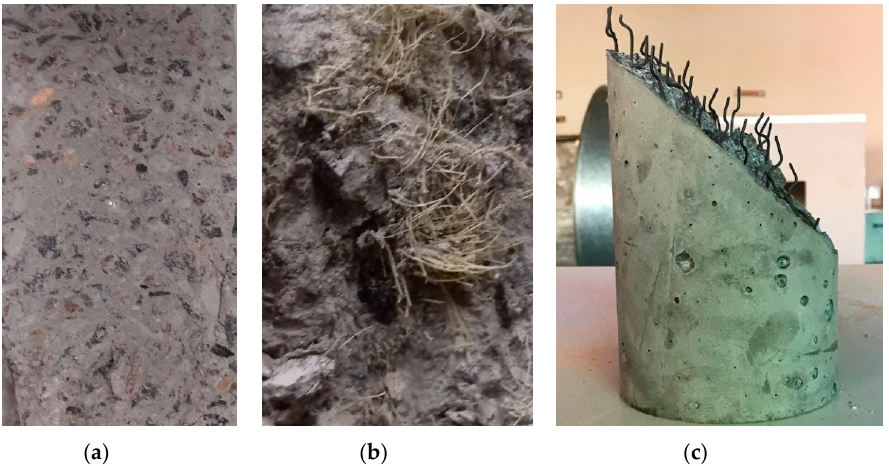
Figure 13. Concrete types. ( a ) Concrete without fiber, ( b ) concrete with sisal fiber, ( c ) concrete with new steel fiber.